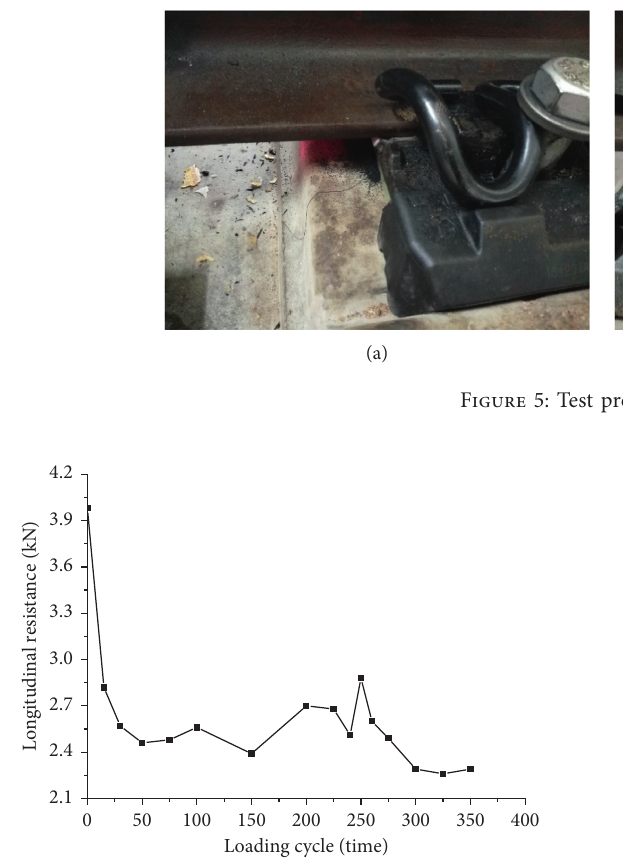
Figure 6: Relationship between longitudinal resistance and the loading cycle at 0.5mm displacement.